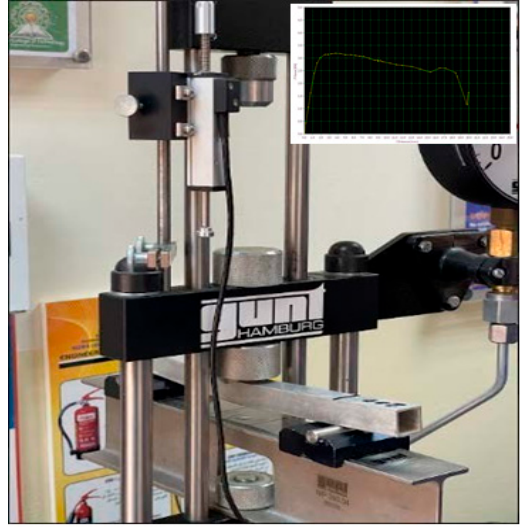
Figure 2. Photograph of experimental setup with a sample output.